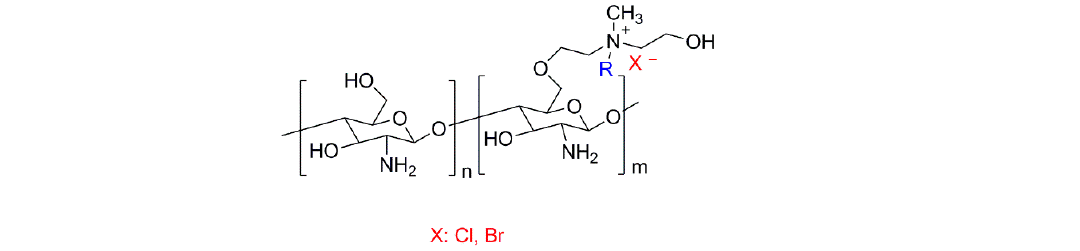
Figure 12. Structures of the O -quaternary ammonium salt chitosan derivatives.